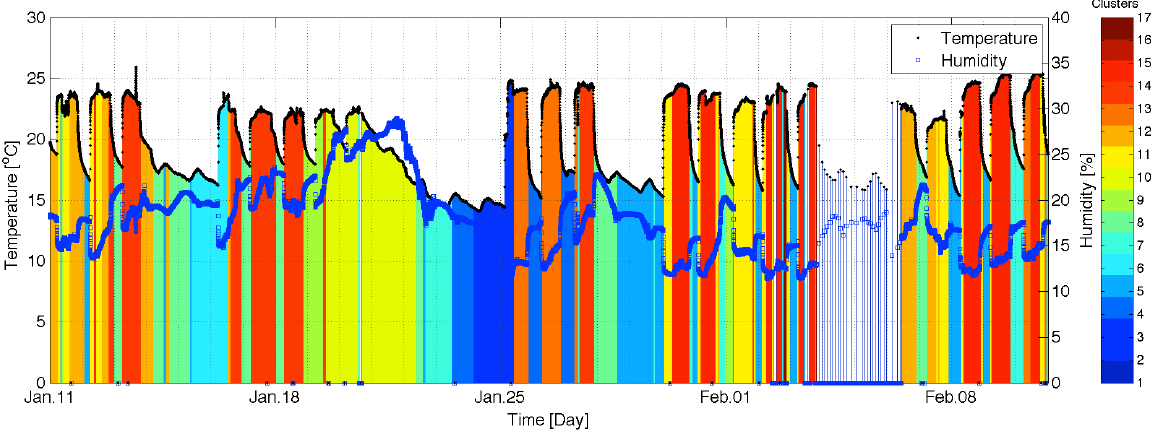
Figure 5. Building environment clusters built with SOM and k -Means algorithm using the temperature and humidity dataset collected from wireless sensor nodes from 11 January 2012 to 10 February